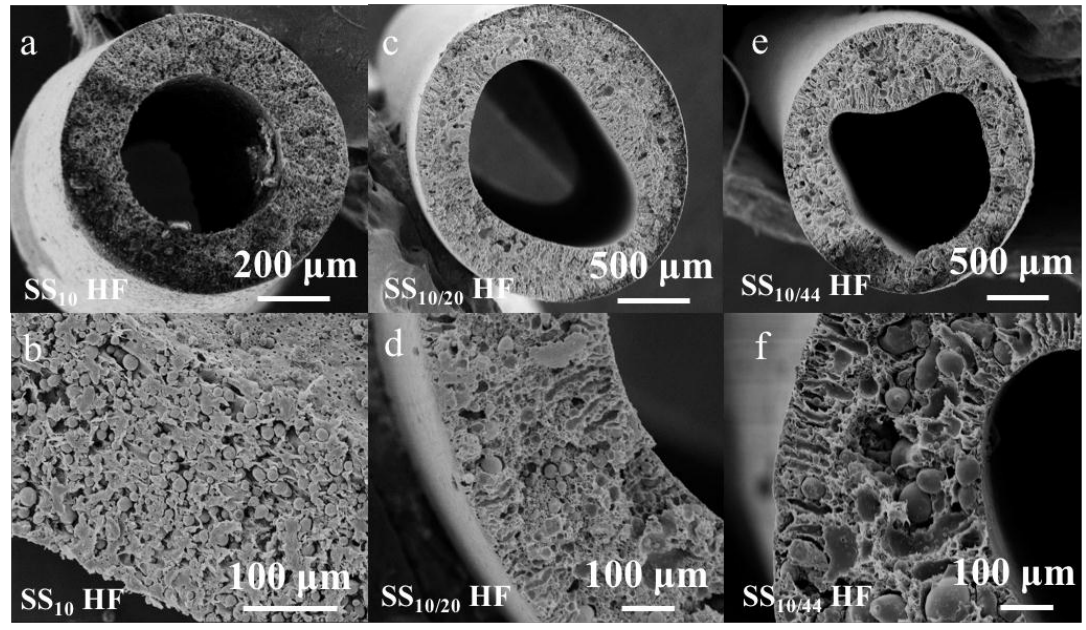
Figure 4. Cross-sectional SEM images of ( a , b ): the SS 10 green hollow-fibers (HFs); ( c , d ): the SS 10/20 HFs; ( e , f ): the SS 10/44 HFs.